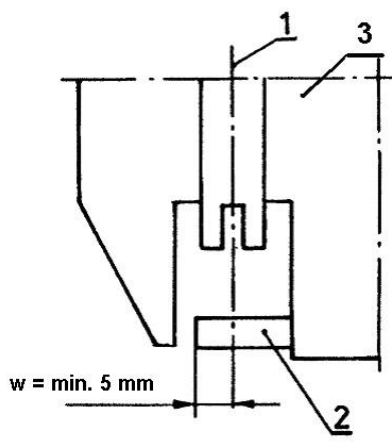
Figure 15. Position of chain catcher in a portable chainsaw. 1: guide bar symmetry plane; 2: chain catcher; 3: chainsaw body.